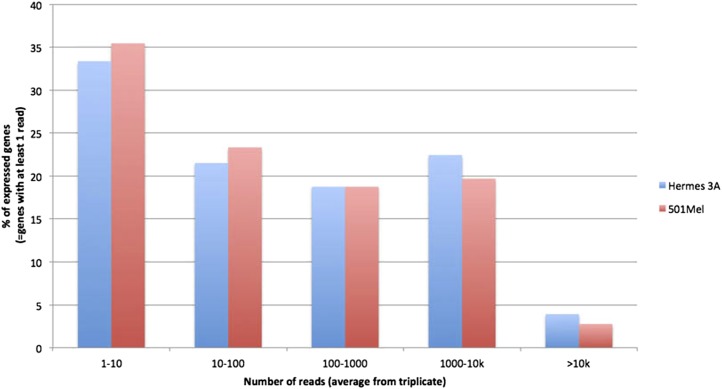
DOI:
http://dx.doi.org/10.7554/eLife.06857.026